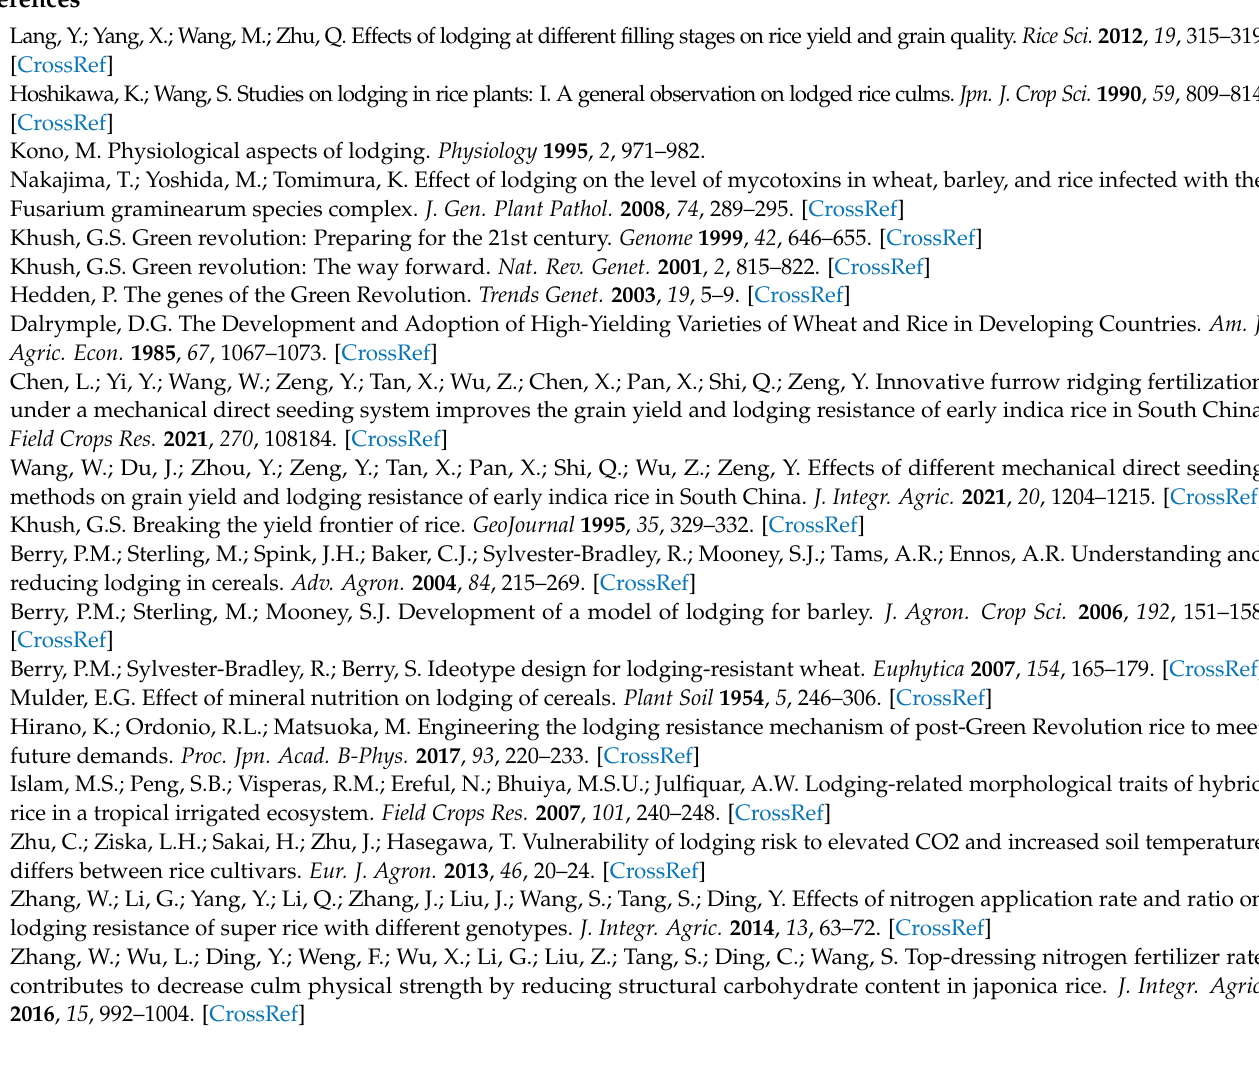
Table S2: Analysis of variance of temperature and solar radiation parameters, LI, and (cid:52)